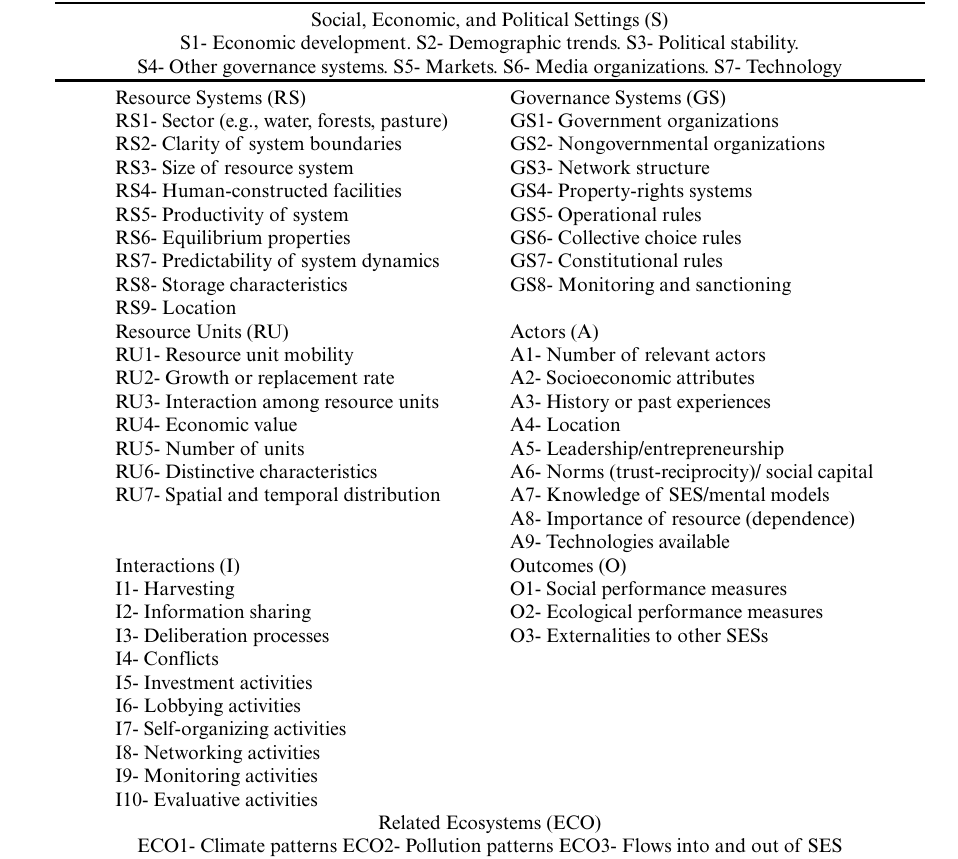
Table 1. The first- and second-tier variables of the social-ecological systems framework from McGinnis and Ostrom